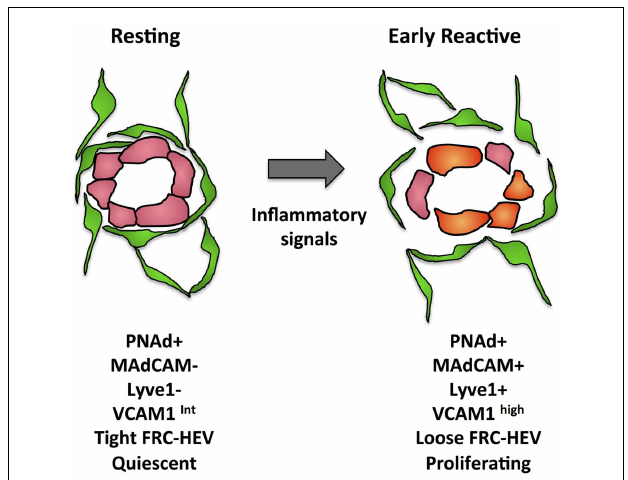
FIGURE 4 | Illustration of some of the changes that occur in the FRC-vascular units during the resting to reactive transition in a lymph node